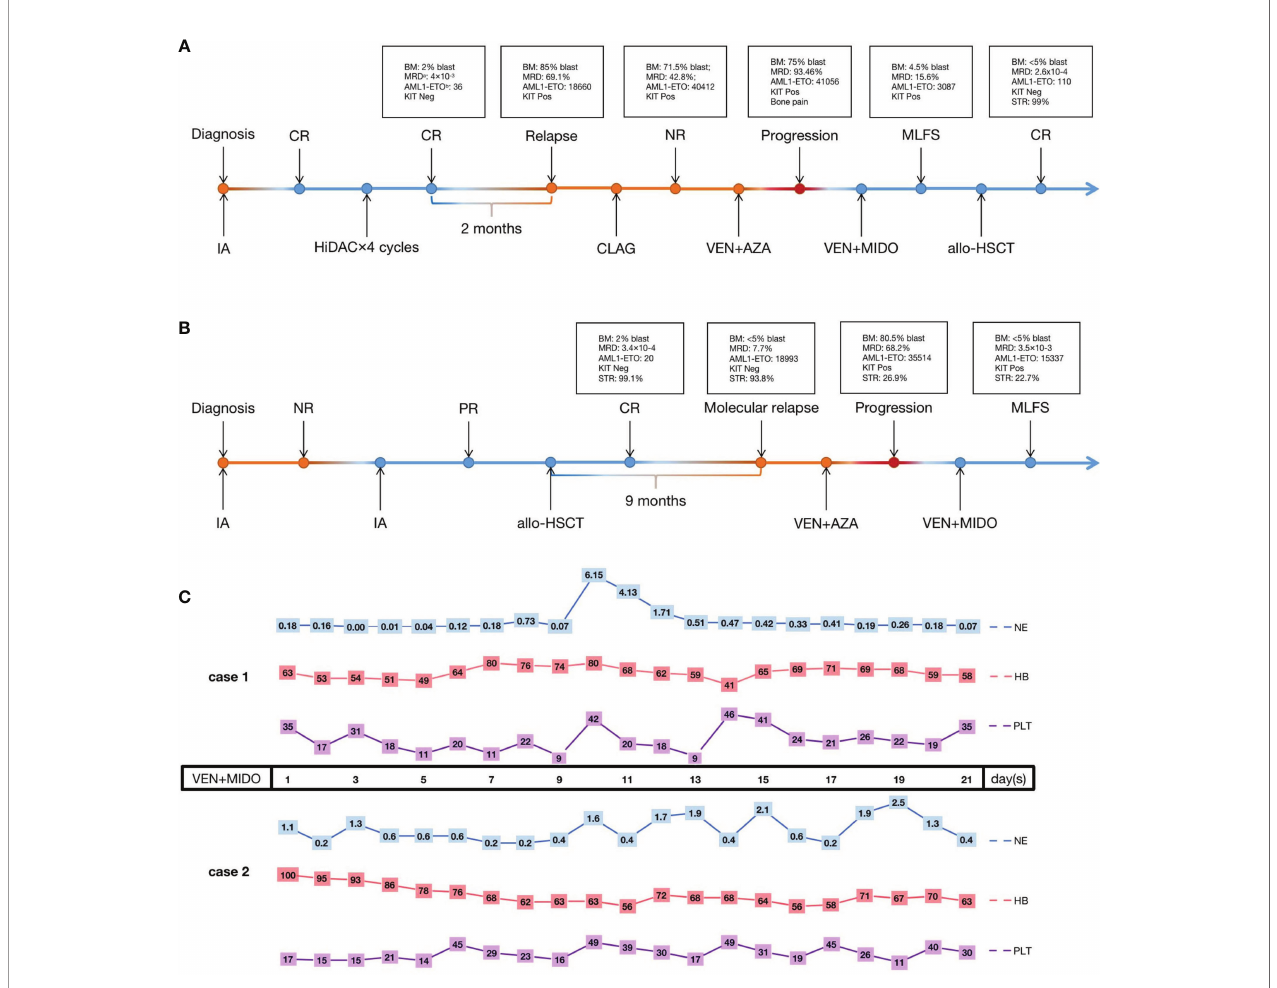
FIGURE 1 | The treatment process of case 1 (A) and case 2 (B) and the hematological toxicity of VEN+MIDO therapy (C) . CR, complete remission; PR, partial remission; NR, non-remission; Neg, negative; Pos, positive; IA, cytarabine 100 mg/m 2 continuous infusion d1-7, idarubicin 12 mg/m 2 d1-3; HiDAC, cytarabine 2 g/ m 2 over 3 h every 12 h on d1-3; CLAG, cladribine 5 mg/m 2 d1-5, cytarabine 2 mg/m 2 d1-5, granulocyte-colony stimulating factor 5 m g/kg d0-5; VEN+AZA, venetoclax once daily (100 mg d1, 200 mg d2, 400 mg d3-28) and azacitidine 75 mg/m 2 d1-7; VEN+MIDO, venetoclax once daily (100 mg d1-21) concurrent with voriconazole, midostaurin twice daily (50 mg d1-21); allo-HSCT, allogeneic haematopoietic stem cell transplantation; MLFS, morphologic leukemia-free state; NE, neutrophils count (×10 9 /L); HB, hemoglobin (g/L); PLT, platelet count (×10 9 /L). a MRD, minimal residual disease detected by multiparameter fl ow cytometry. b AML1- ETO, the presence of the AML1-ETO fusion gene calculated with standard materials, normalized with respect to the number of ABL1 transcripts and expressed as copy numbers per 1×10 4 copies of